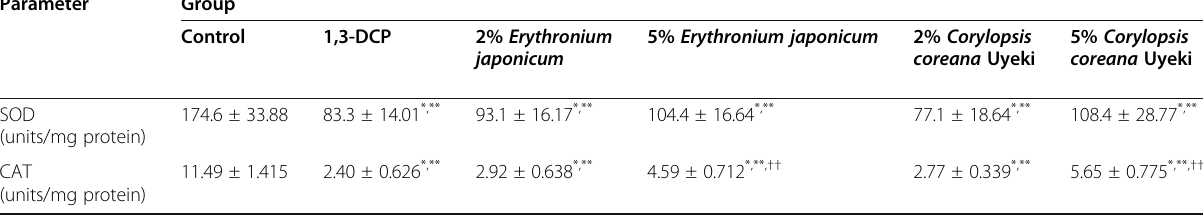
Table 3 Superoxide dismutase (SOD) and catalase (CAT) activities in the rat liver